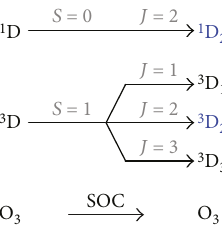
for a Ti 4+ ion into D , D , and D . 3d 1 2 3